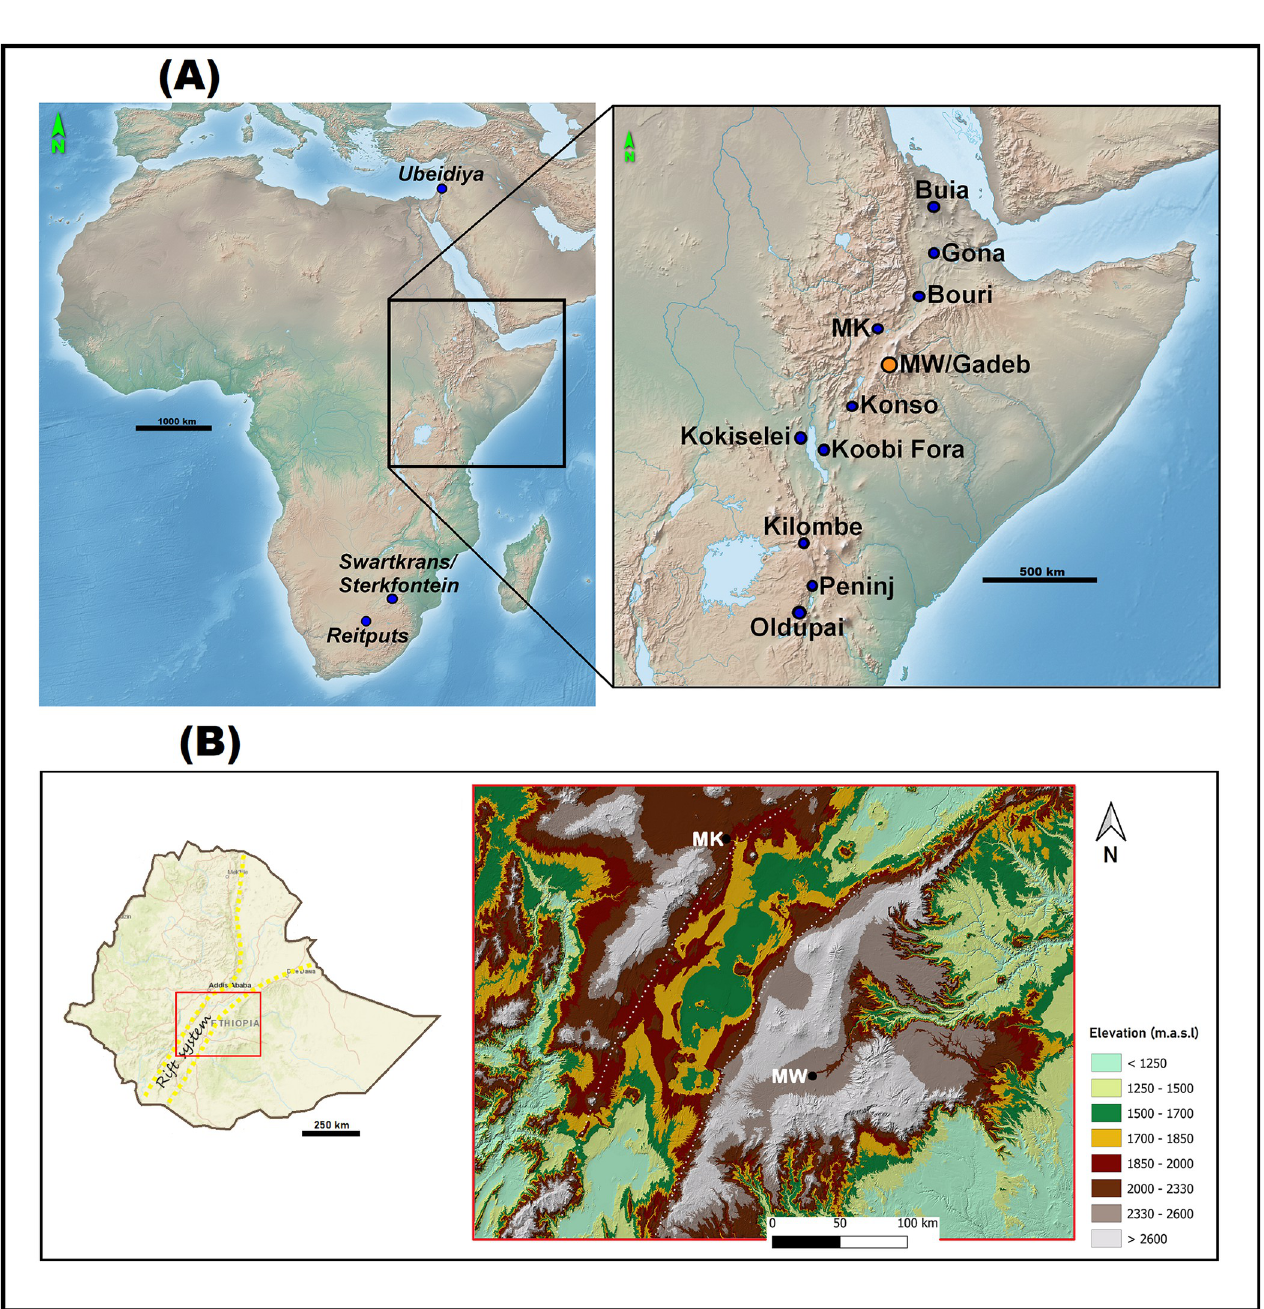
boundaries of the Main Ethiopian Rift are marked by white dotted lines. MK = Melka Kunture site-complex. DEM from USGS National Map Viewer (public domain): http://viewer.nationalmap.gov/viewer/. The map was created by authors in